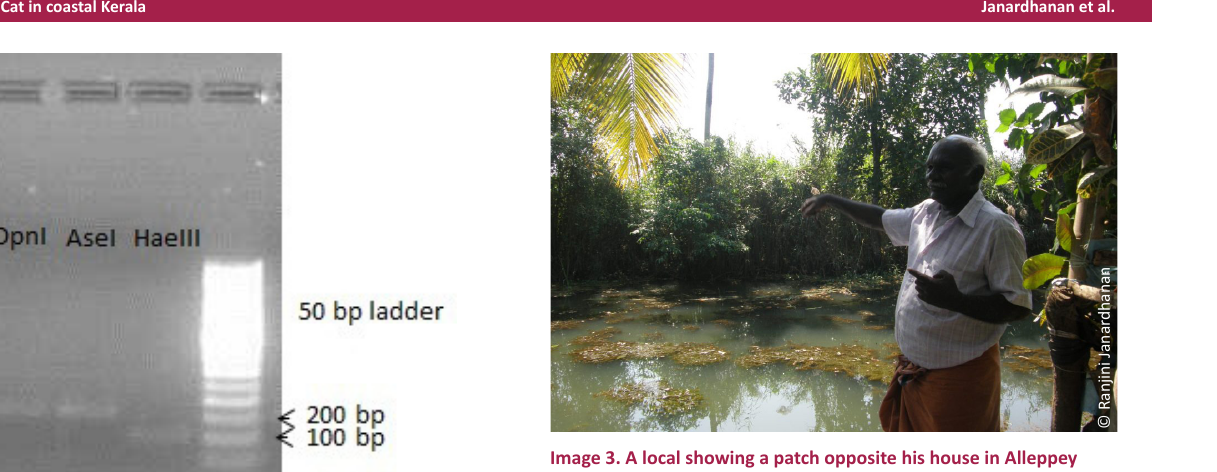
where a wild cat visits regularly. He said the cat comes to catch